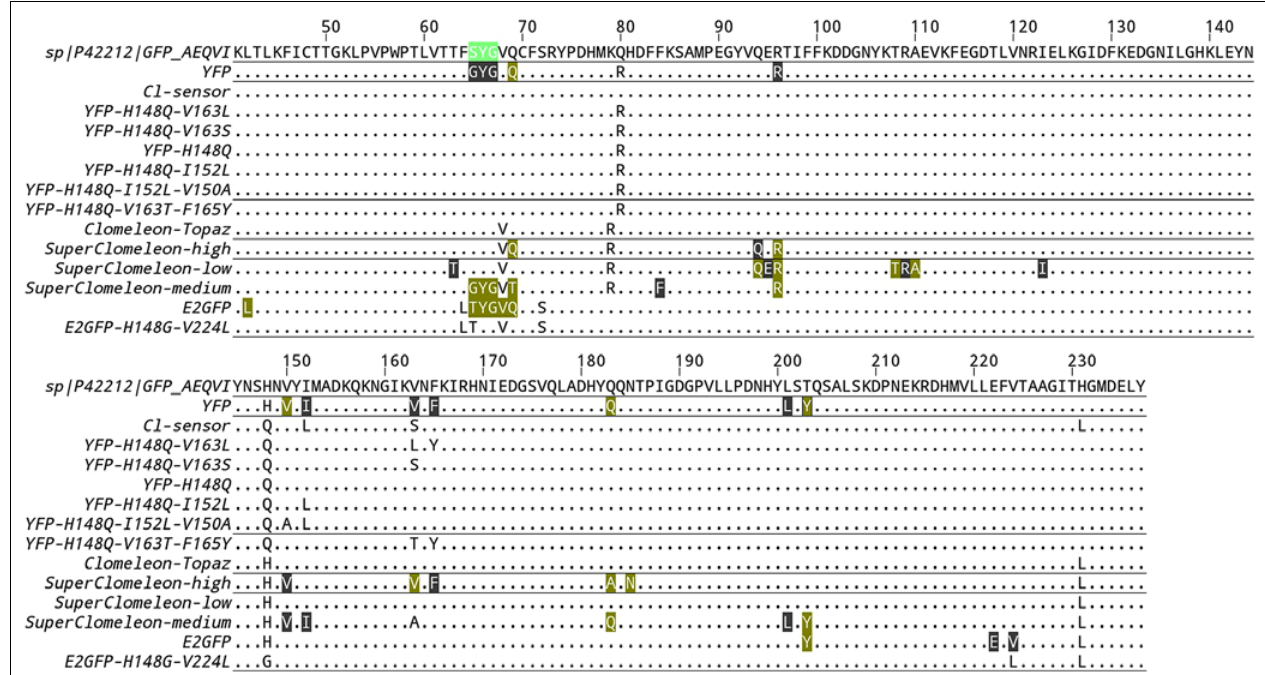
FIGURE 1 |Alignment of chloride binding GFP variants. Only residues that differ from the reference wild-type GFP sequence (UniProtKB entry P42212) are indicated. If the protein data bank contains structural information of a given GFP variant, the residues of the chloride binding site are boxed. Color